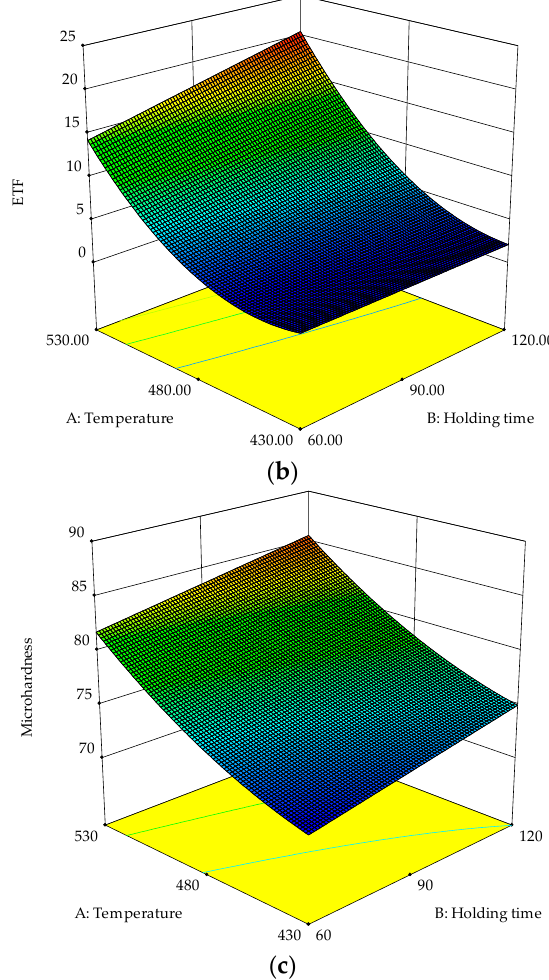
Figure 6. 3D surface graphic of the factors for ( a ) UTS, ( b ) ETF, and ( c ) MH.